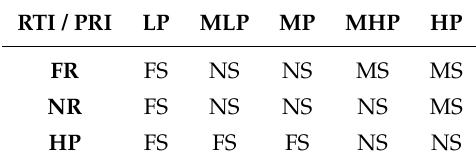
Table 3. The rule table for the Stimuli Number output.